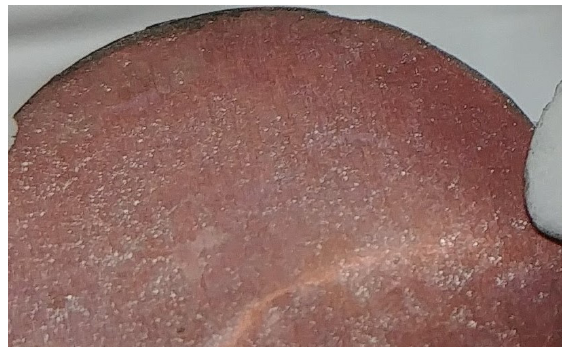
Figure 6. Photograph of the backside of a lithiated structured current collector. (The side that was averted from the separator). Li deposits are clearly visible as fine white